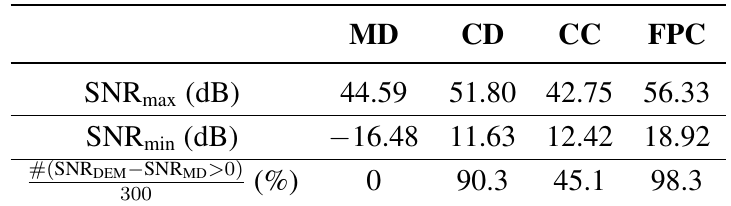
Table 1. Maxima and minima SNR levels obtained by each demodulation technique for the 300 simulated scenarios (Rows 1 and 2). The centroid detection (CD) and the fast phase correlation (FPC) yield a higher SNR for more than 90% of the simulated scenarios, while the cross-correlation (CC) performs better than maxium detection (MD) only for 45.1% of the cases.